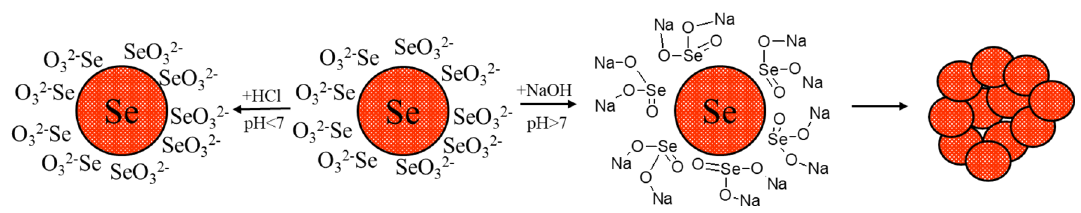
Figure 19. Scheme of coagulation for the negative Se NPs